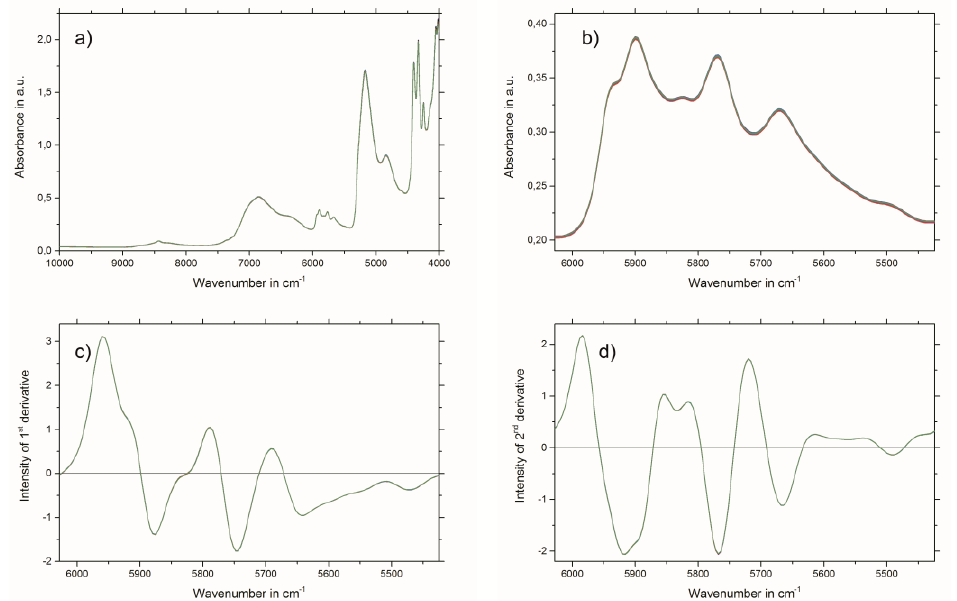
Figure 2. ( a ) Raw near-infrared (NIR) spectra of all 90 samples; ( b ) section from the raw NIR spectra showing the wavenumber region used for PLSR model calculation; ( c ) first derivate (13 smoothing points) and standard normal variate (SNV)-transformed NIR spectra region used for total hydroxycinnamic derivatives (THCD) in mg/kg and gallic acid equivalents (GAE)% PLSR model calculation; and ( d ) second derivate (23 smoothing points) and SNV-transformed NIR spectra region used for rosmarinic acid (RA)% PLSR model calculation.